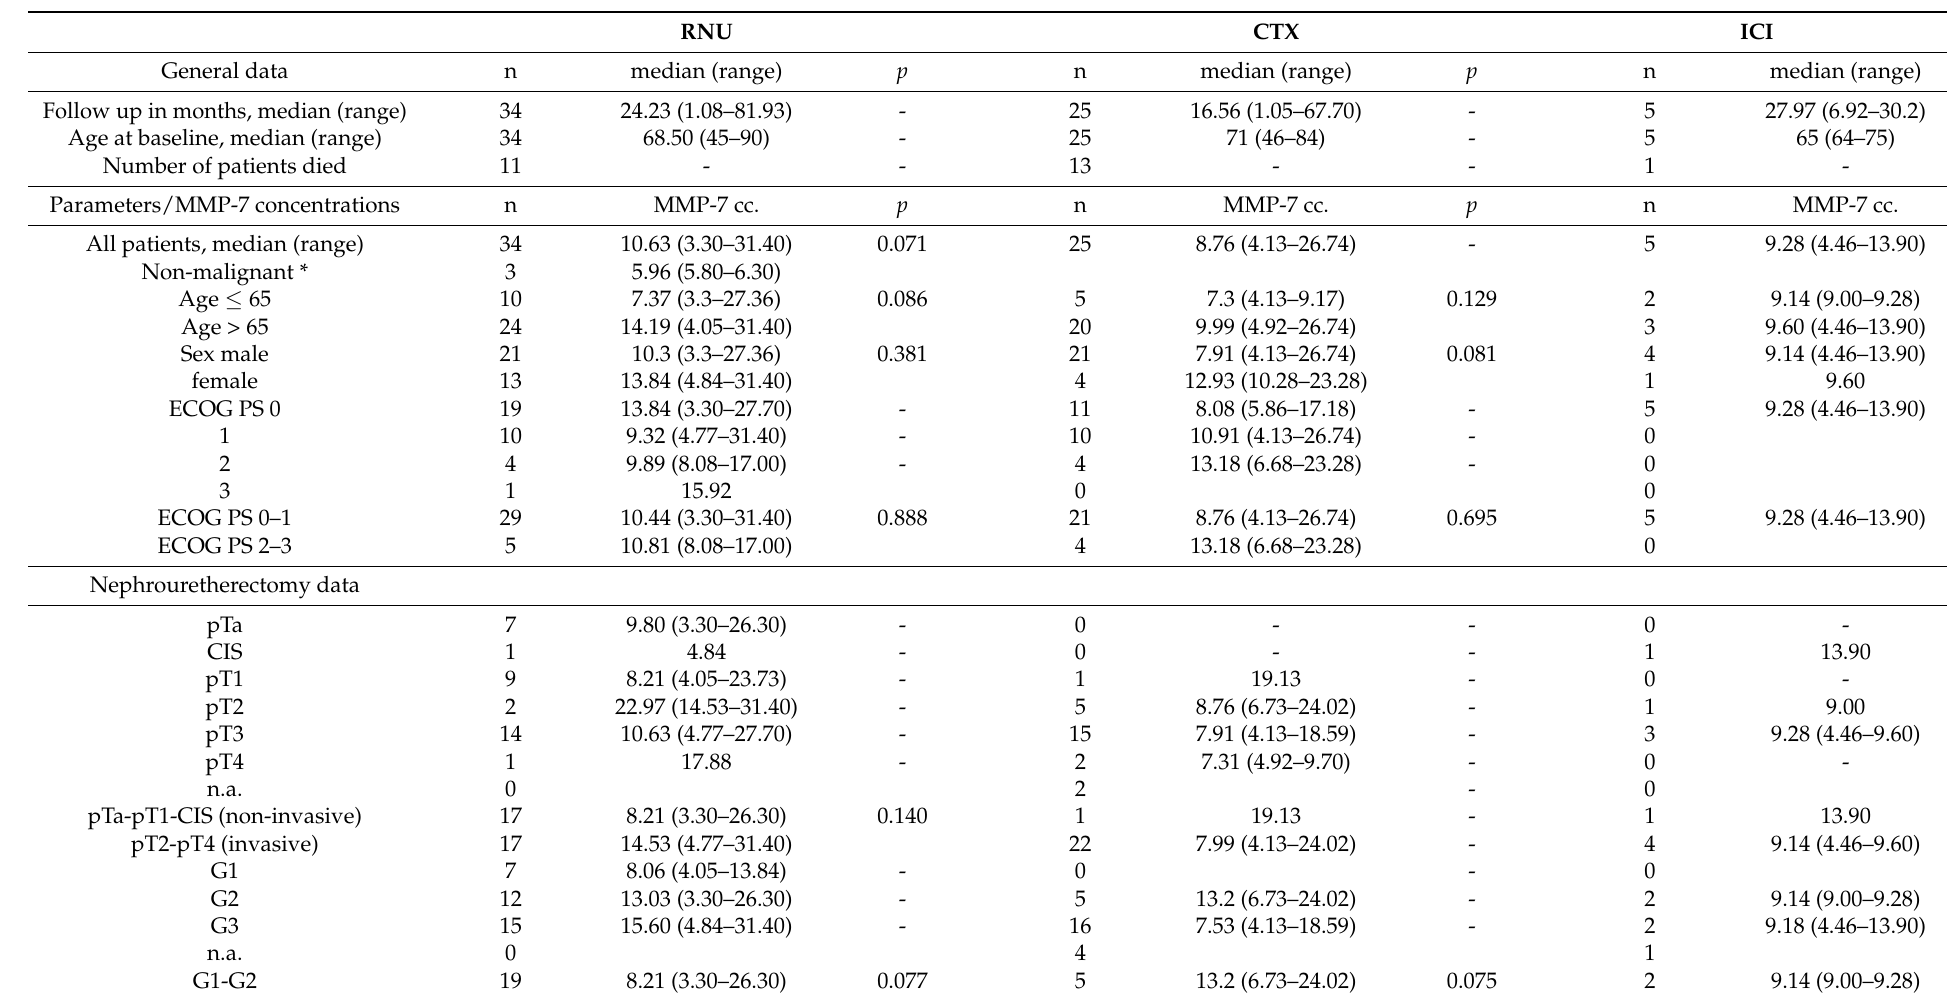
Table 1. Patients’ characteristics. * Non-malignant—in three cases of RNU, histological examination resulted in a pT0 finding; RNU—radical